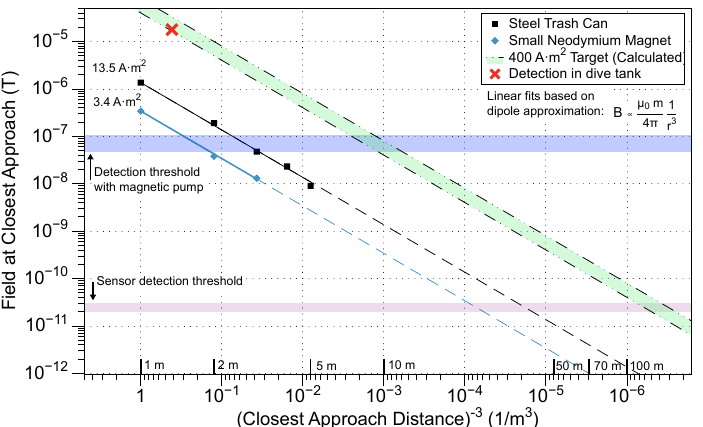
Figure 9. Reference data for detection capabilities. The maximum range of the sensor varies strongly depending on both the magnetization of the target and its distance from the sensor, since the field decreases inversely proportional to the cube of